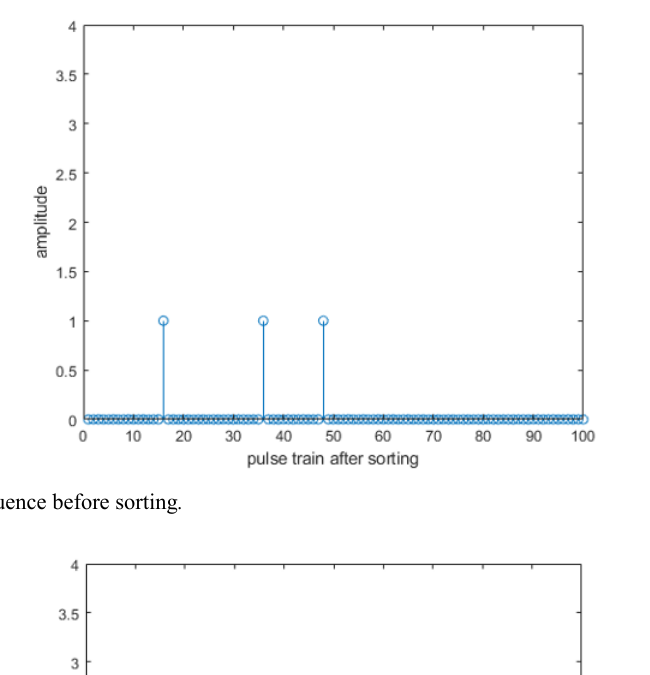
Fig. 4. Pulse sequence before sorting .